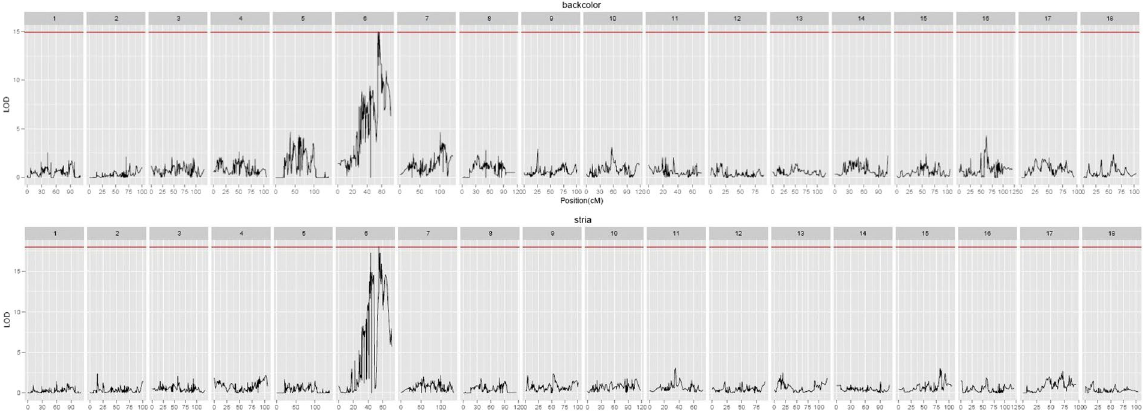
Figure 4. Shell color QTL mapping and association analysis in R. philippinarum among all linkage